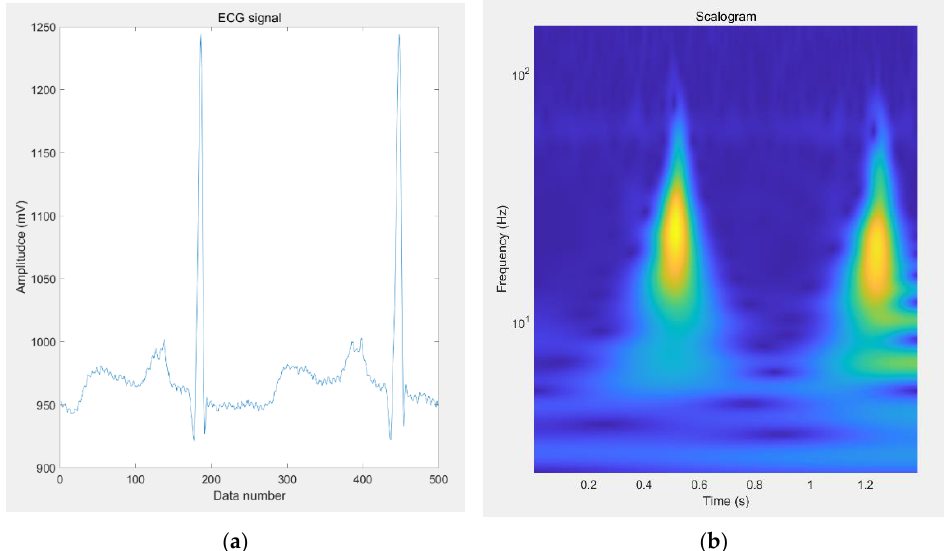
Figure 5. Scalogram was used to investigate the frequency characteristics of the ECG signals. A higher voltage of the signal corresponded to a clearer scalogram result. ( a ) ECG signal; ( b ) scalogram of the ECG signal.